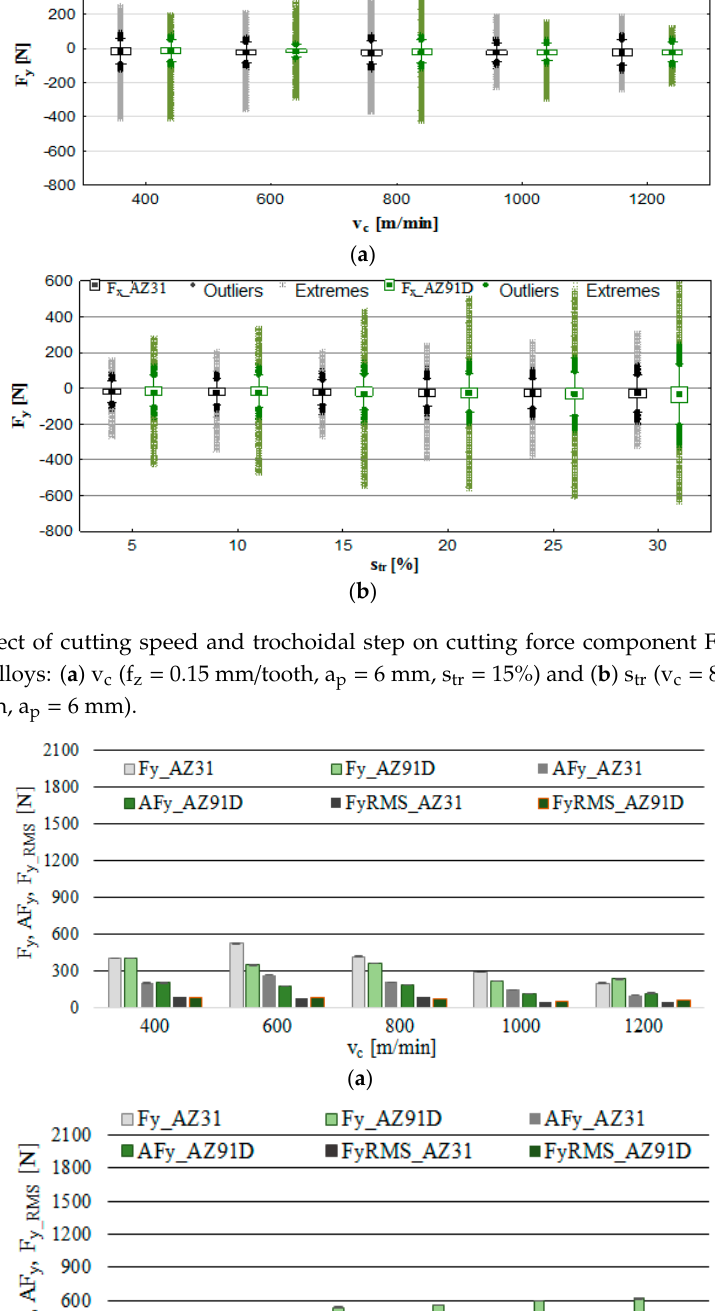
Figure 7. Maximum value of cutting force component F y , amplitude and root mean square (RMS) in the milling of magnesium alloys: ( a ) effect of cutting speed v c (f z = 0.15 mm/tooth, a p = 6 mm, s tr = 15%) and ( b ) effect of trochoidal step s tr (v c = 800 m/min, f z = 0.15 mm/tooth, a p = 6 mm).